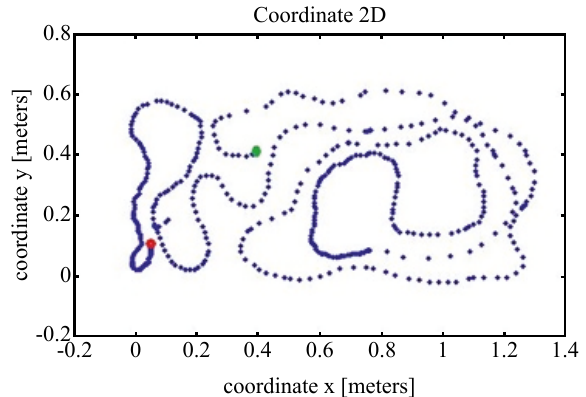
Figure 2 . Image of the 10 meters route from the X, Y coordinates in 2D, obtained by one of the three evaluators. Green dot = beginning of the trace; red dot = end of the trace.